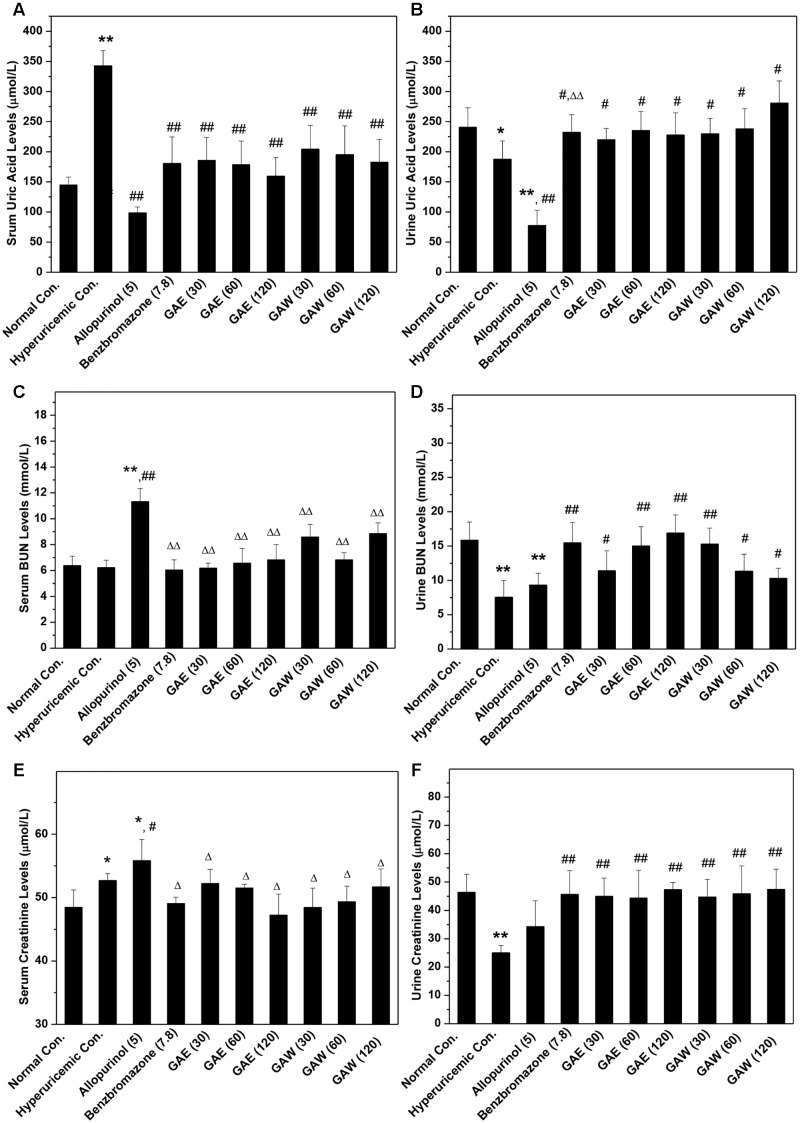
Effects of G. applanatum on serum uric acid (A), BUN (B), and creatinine (C) and urine uric acid (D), BUN (E), and creatinine (F) in mice. ∗P < 0.05, ∗∗P < 0.01 compared to the normal control; #P < 0.05, ##P < 0.01 as compared to the hyperuricemia control; ΔP < 0.05, ΔΔP < 0.01 compared to the allopurinol control.